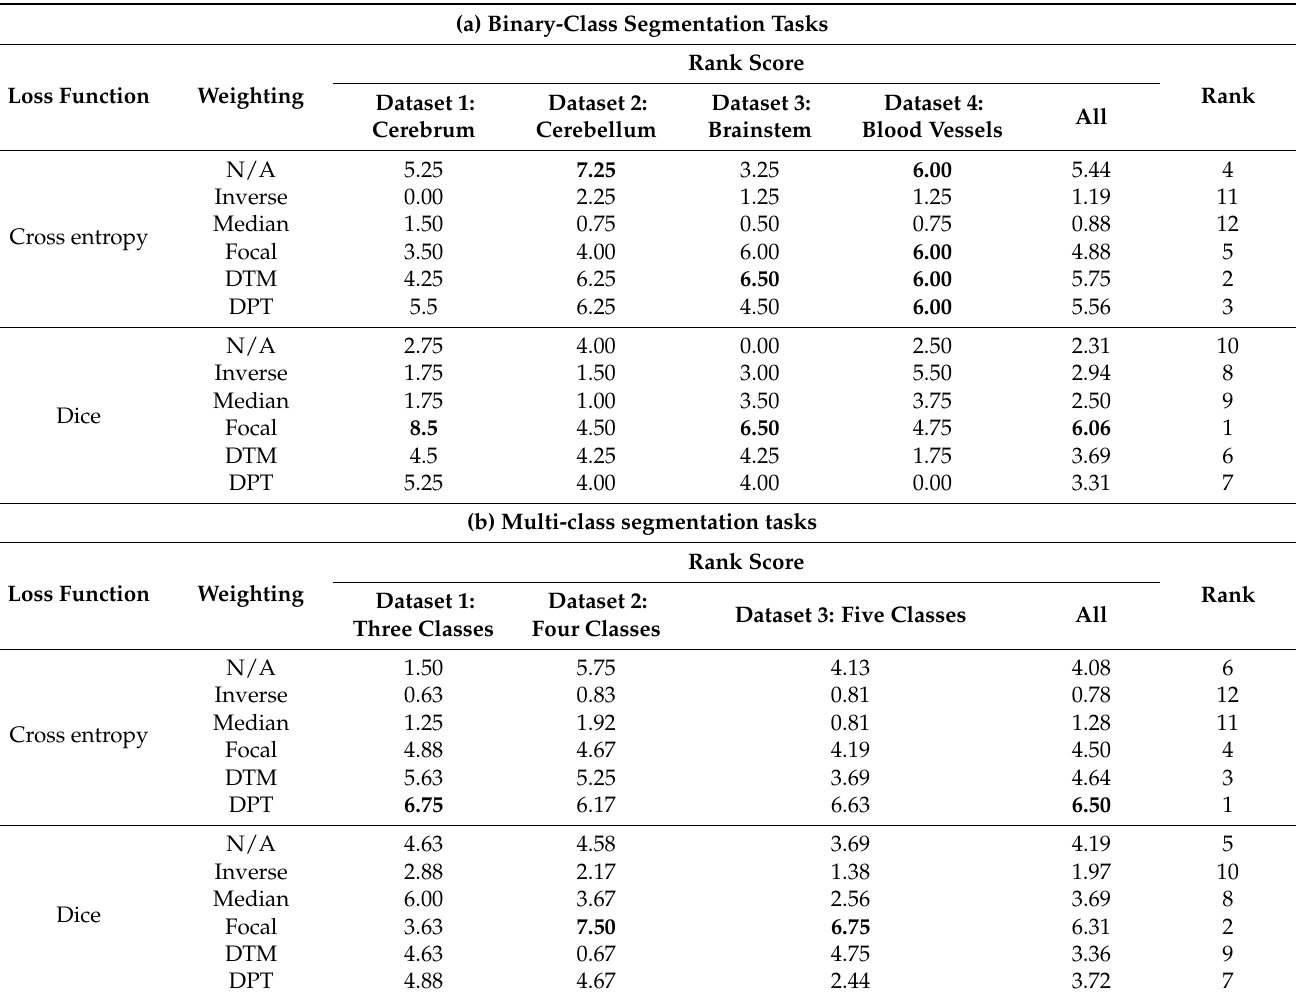
Table 6 indicates the ranking results of loss weightings in the binary- and multi-class segmentation tasks. The distance map-based weightings for cross-entropy loss function and the predictive-probability weighting for Dice loss function tended to have high rank scores in both the binary- and multi-class segmentation tasks. In the binary-class segmentation tasks, the Dice loss function with Focal showed the best ranking result. It actually obtained a high average DSC and SDSC of 92.8% and 93.3%, respectively. Compared with no weighting, it improved the DSC and SDSC values of all tasks by 0.2–8.1% and 0.5–12.5%, respectively. In the multi-class segmentation tasks, the cross-entropy loss function with DPT had the highest rank score, followed by the Dice loss function with Focal. In the five-class segmentation task, DPT achieved the highest average DSC and SDSC values of 93.1% and 94.6%, respectively. Table 6. Ranking results of no weighting (N/A), inverse frequency weighting (Inverse), inverse median frequency weighting (Median), focal weighting (Focal), distance transform map-based weighting (DTM), and distance penalty term-based weighting (DPT) in (a) binary-class segmentation tasks and (b) multi-class segmentation tasks. The best results are shown in bold. The rank is determined based on the rank scores of segmentation results on all